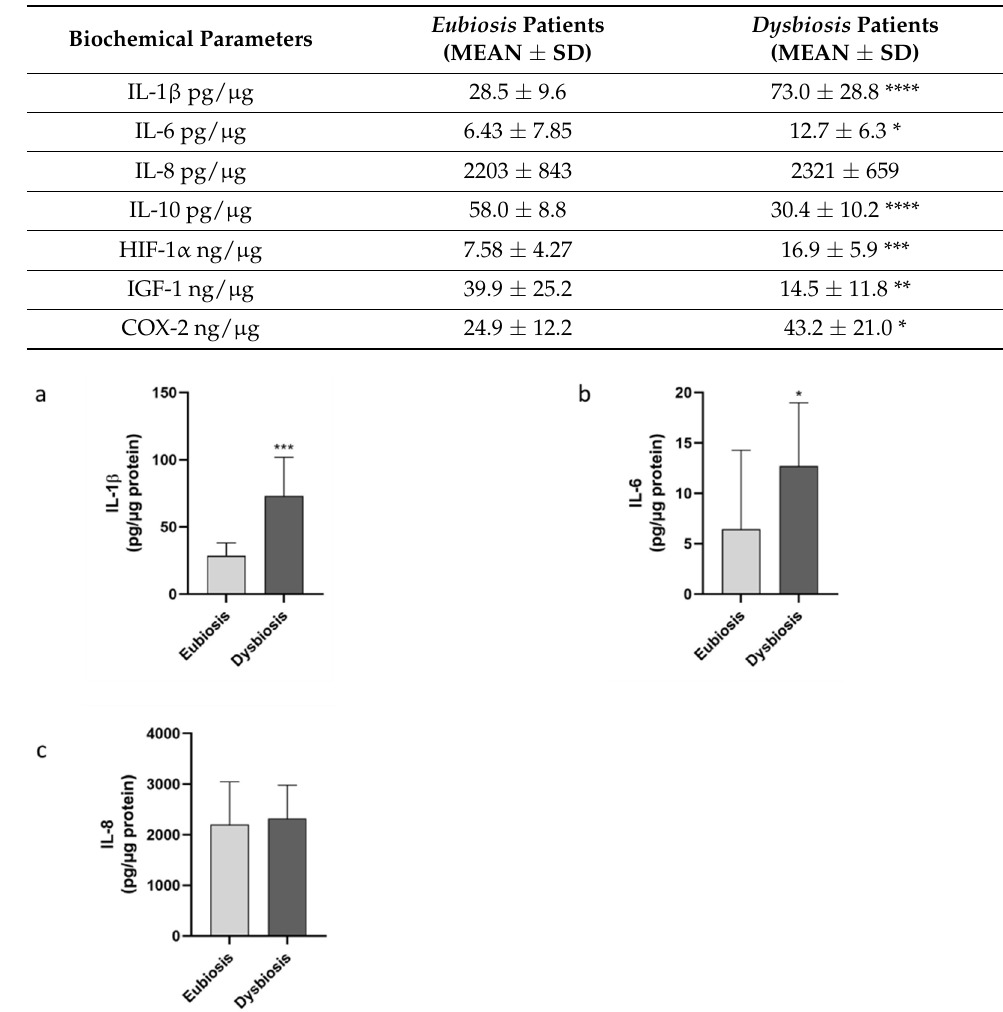
Figure 3. Evaluation of inflammatory molecules. The inflammatory markers were quantified in the two different groups by specific immunoenzymatic assay. In particular, the levels of IL-6 ( a ), IL-1 β ( b ) and IL-8 ( c ) were analyzed. The data are the mean ± SEM of three different experiments, each performed in duplicate. Statistical analysis was performed by unpaired t-test: * p < 0.05, *** p < 0.001 vs. eubiosis group. Table 4. Biochemical parameters measured in the two study groups. The data are expressed as mean ± SD. Statistical analysis was performed by unpaired t -test. * p < 0.05, ** p < 0.01, *** p < 0.001 **** p < 0.0001 vs. eubiosis patients.